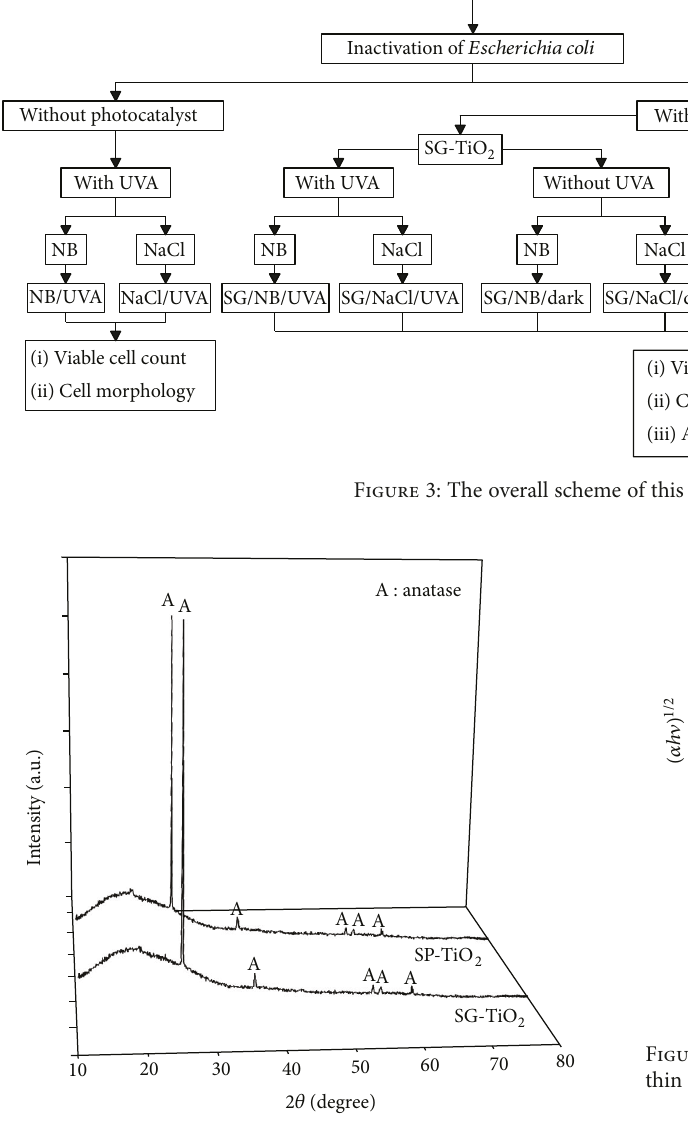
and SP-TiO thin fi lms. 2 2